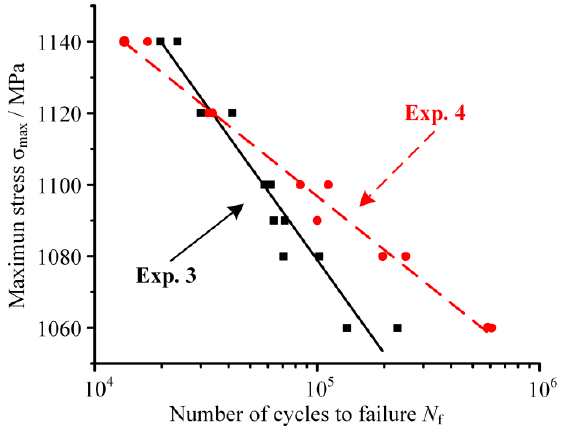
Figure 5. Fatigue life of TC17 specimens under different load conditions.